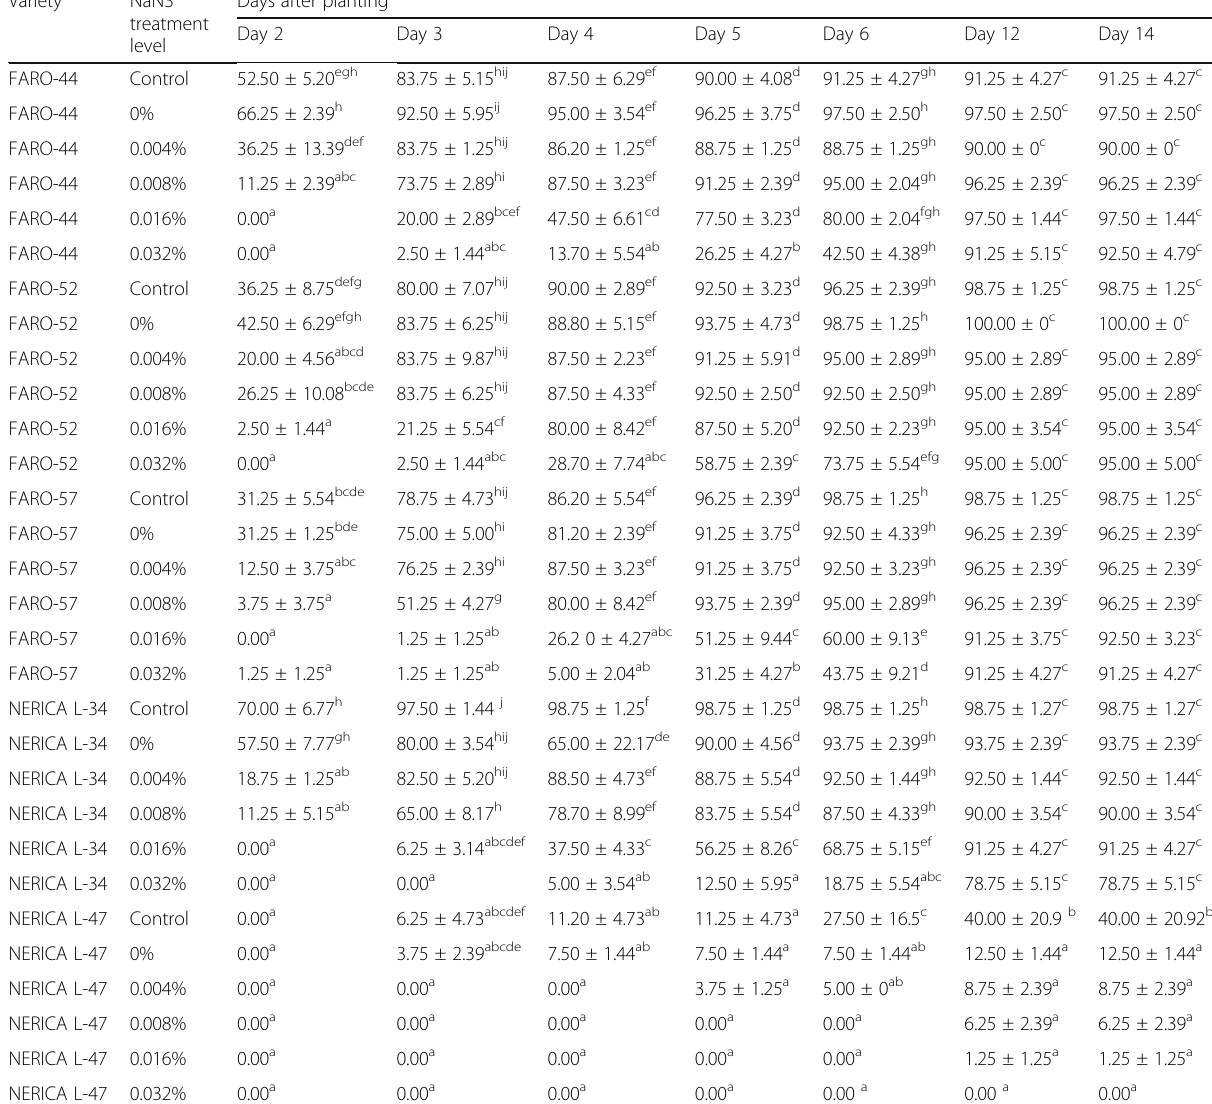
Mean ± standard error. Mean of four replicates. Different alphabets in columns indicate significant differences at 5% level of